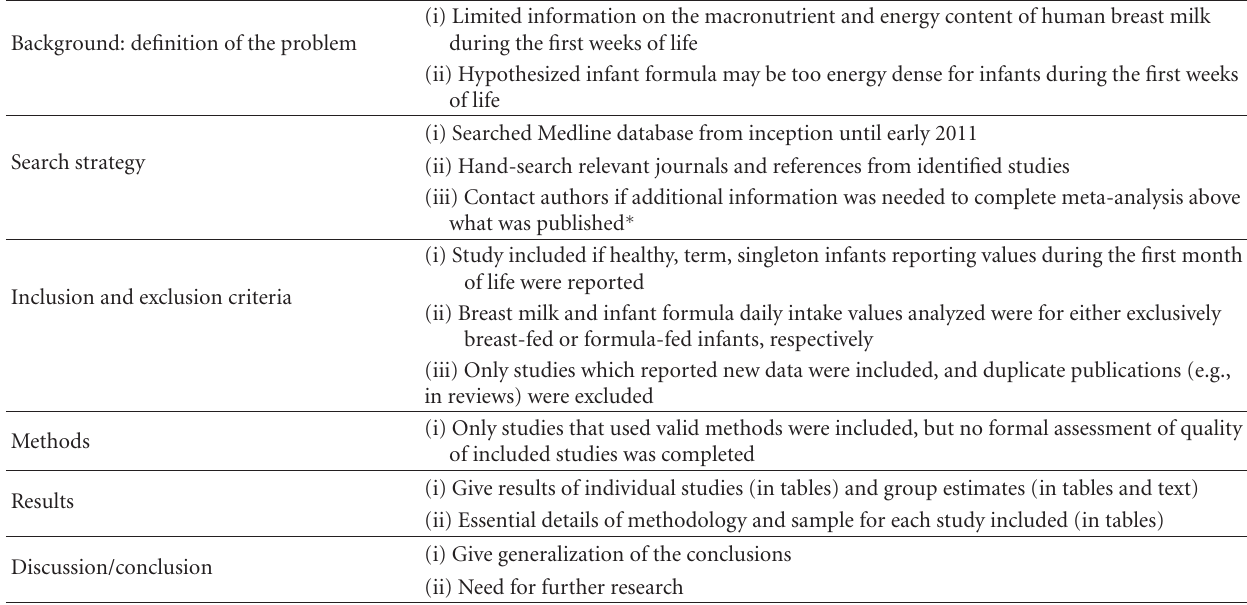
Table 1: Checklist for reporting systemic reviews, using the meta-analysis of observational studies in epidemiology [17]. Background: definition of the